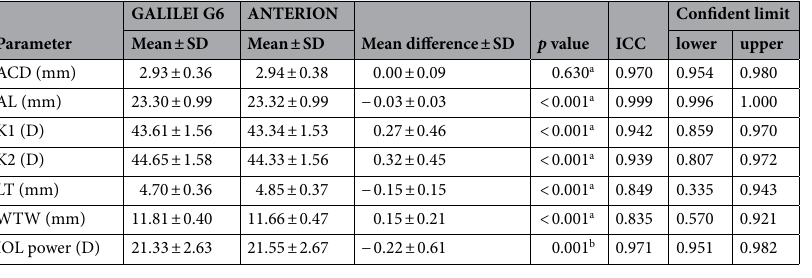
Table 2. Comparison and Intraclass correlation coefficient of various biometric parameters between GALILEI G6 and ANTERION. Values are presented as mean ± SD. a p -value from independent t -test . b p -value from Mann–Whitney U test